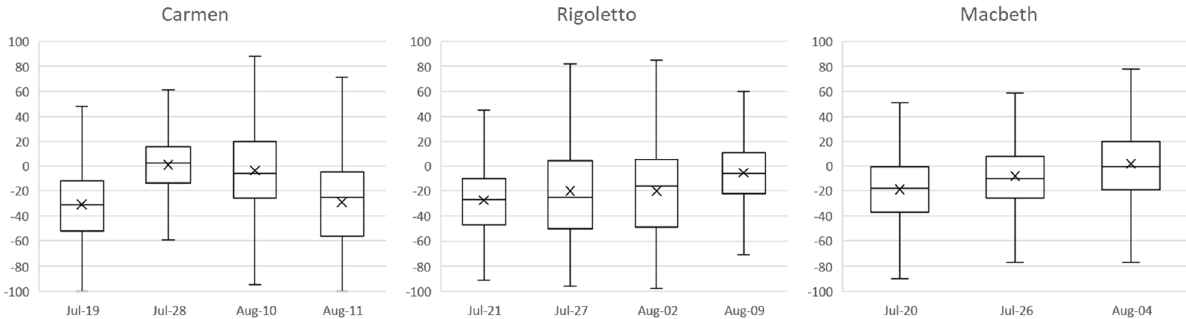
Figure 5. Emotional valence registered during each